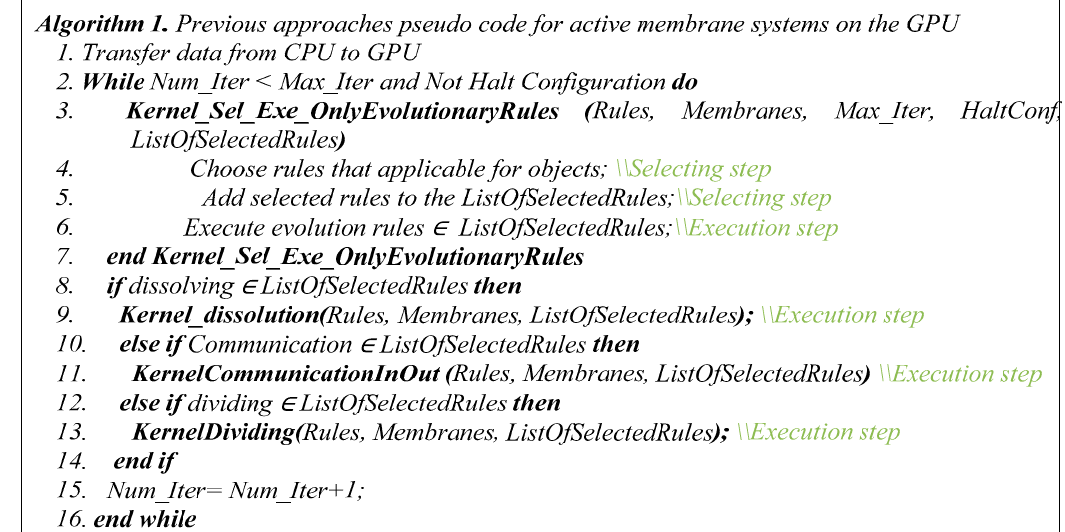
Figure 2. A membrane is assigned to one thread block, and objects are assigned to threads within each thread block [31–33].